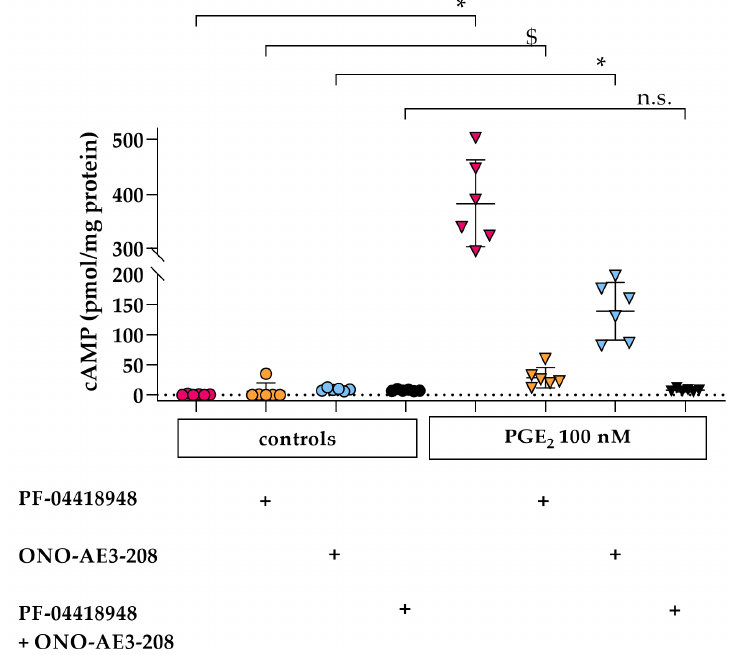
Figure 1. Intracellular cAMP levels in hPC are increased by PGE 2 stimulation (100 nM, pink triangles) in a time-dependent manner. For several controls (blue circles), cAMP levels fell below the lowest concentration of the recommended standard curve (0.78 pmol / mL) and were therefore set to zero. Each data point represents the mean ± SD of one experiment with n = 3–4 samples per time-point.